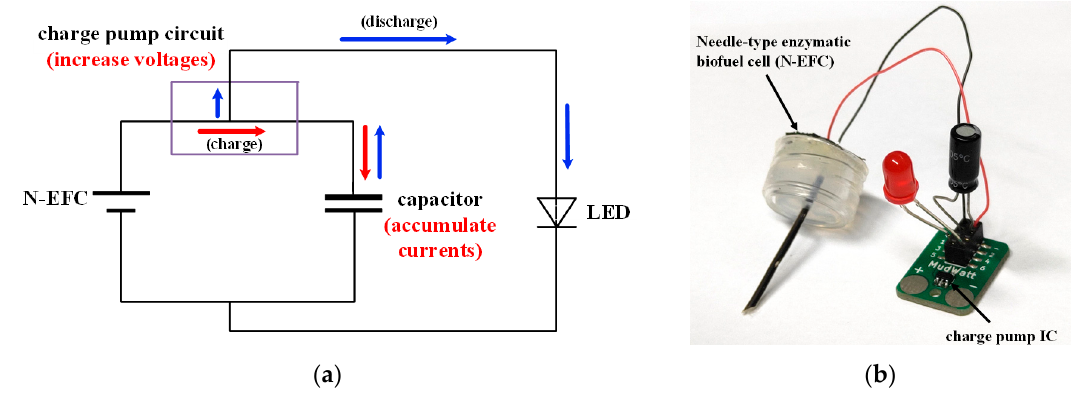
Figure 6. ( a ) Schematic and operation principle of the SPGB and ( b ) an image of the self-powered glucose biosensor (SPGB). The N-EFC was connected with a charge pump circuit consisting of an ultra-low voltage operation charge pump IC, 10 μ F capacitor and red LED as the indicator.